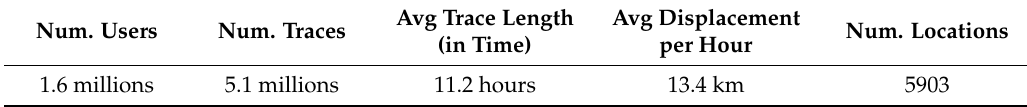
Table 1. Summary characteristics of the pre-processed dataset. Num.